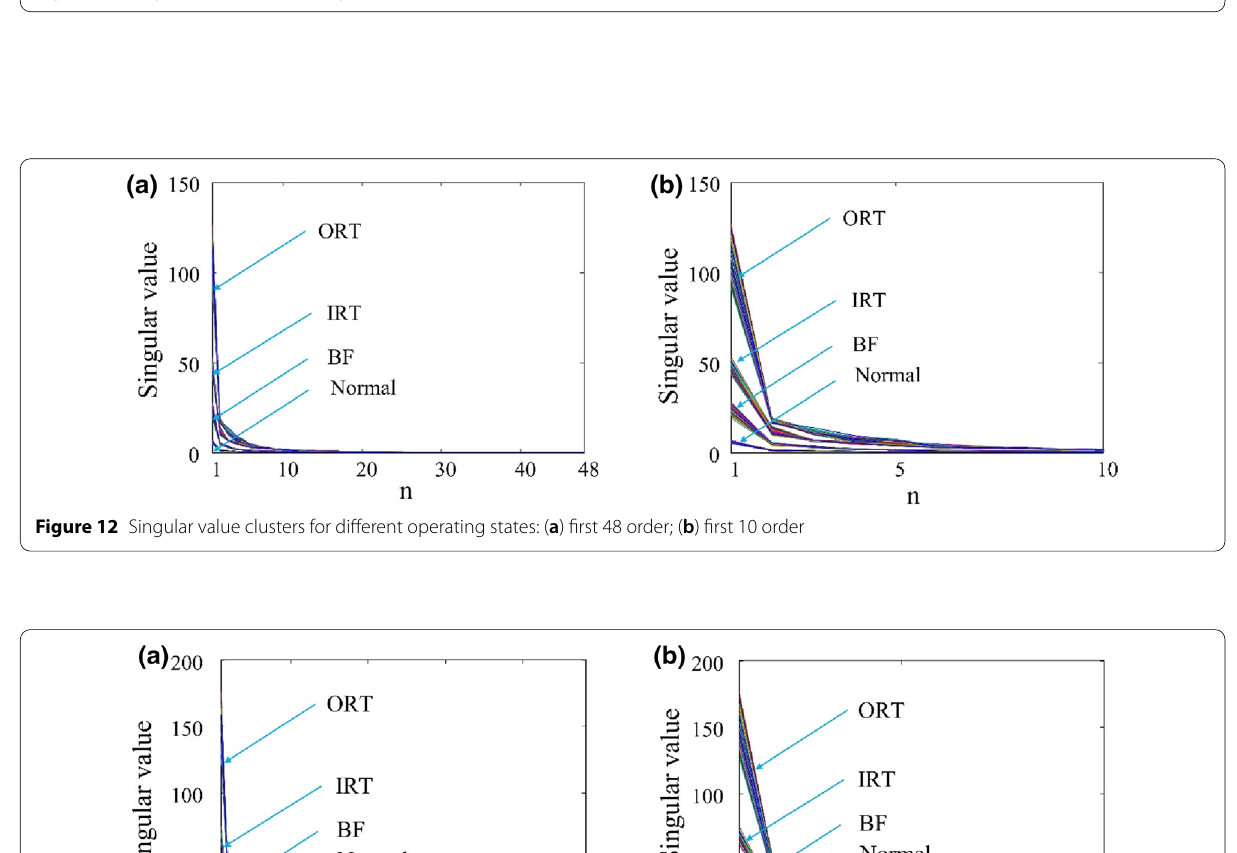
Figure 11 Singular values obtained by standard S transform and SVD: ( a ) normal, ( b ) IRF, ( c ) ORF, ( d ) BF